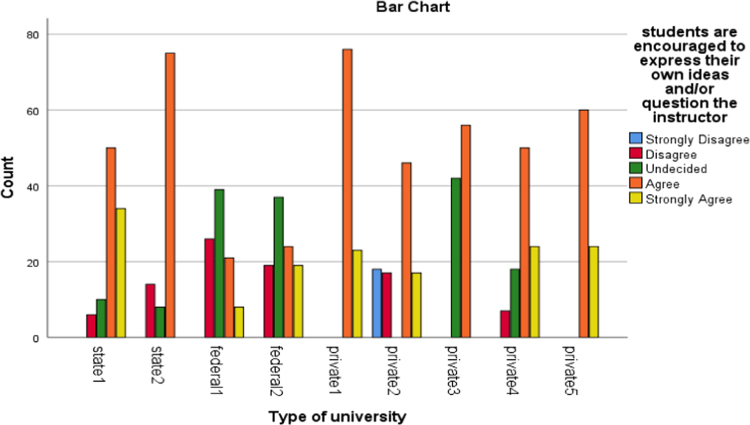
Group discussion.